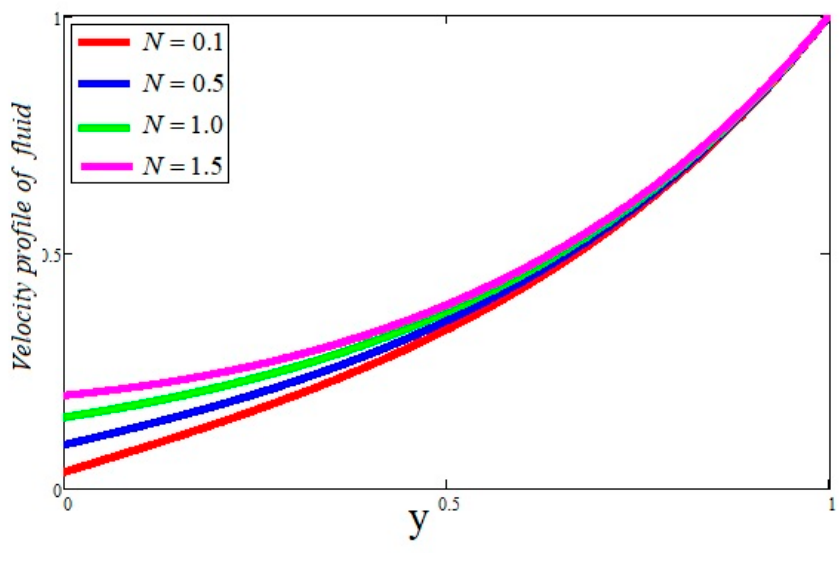
Figure 6. The behavior of N on velocity profile (fluid).